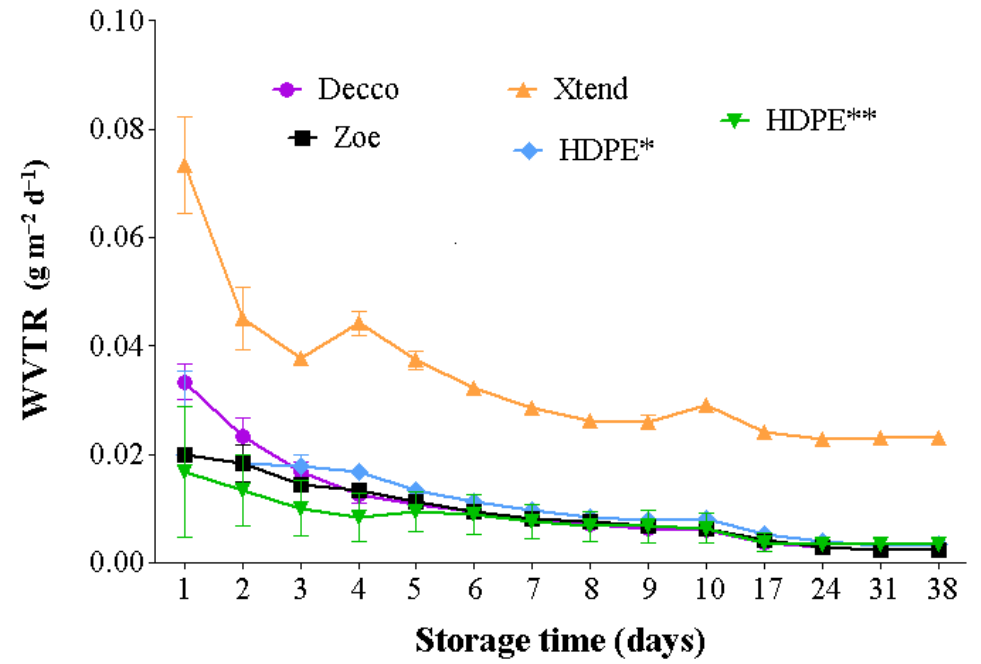
Figure 2. Water vapor transmission rate (WVTR) across plastic liner films under a controlled environment of 5 °C and 90% relative humidity (RH). The non-perforated film section of the 2 mm HDPE (*) and 4 mm HDPE (**) liners were used. HDPE: high density polyethylene.